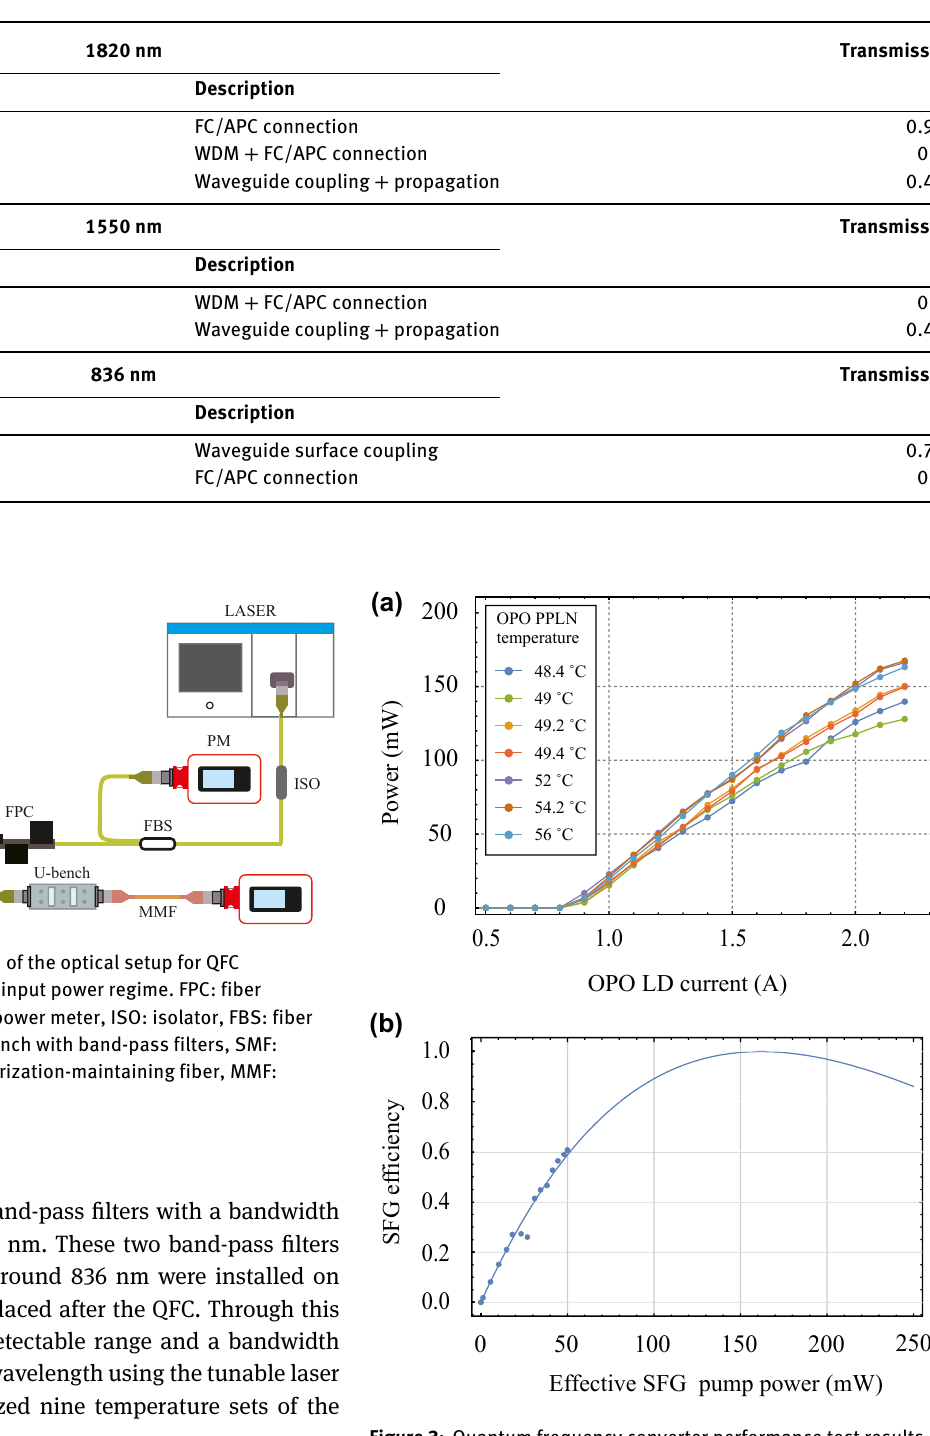
Figure 3: Quantum frequency converter performance test results using the tunable laser. (a) Pump power measured by port 2 in Figure 1 according to laser diode (LD) current at the seven OPO PPLN temperatures. (b) SFG conversion efficiency as a function of the effective SFG pump power (effective SFG pump power = pump power × coupling efficiency from Figure 1, 2 to